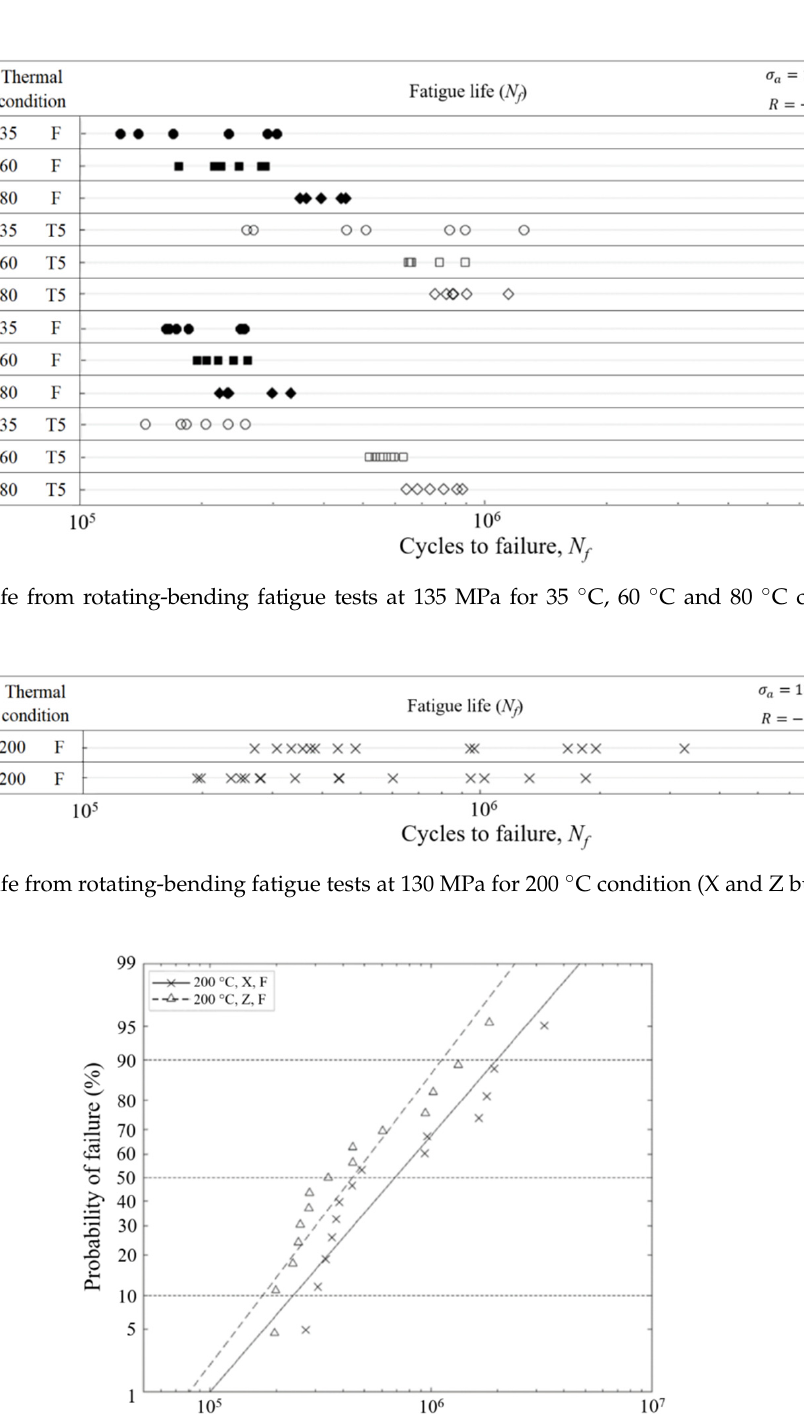
Figure 11. Probability of failure (%) vs. number of load cycles, N . The probability density function of log-normal distributions is fitted to each series of experimental results. The stress amplitude was 130 MPa for the 200 °C, X and Z building conditions. ( a ) ( b ) Figure 12. Probability of failure (%) vs. number of load cycles, N . The probability density function of log-normal distribu- tions is fitted to each series of experimental results. The stress amplitude was 135 MPa for the 35 °C, 60 °C and 80 °C, X ( a ) and Z ( b ) building conditions.